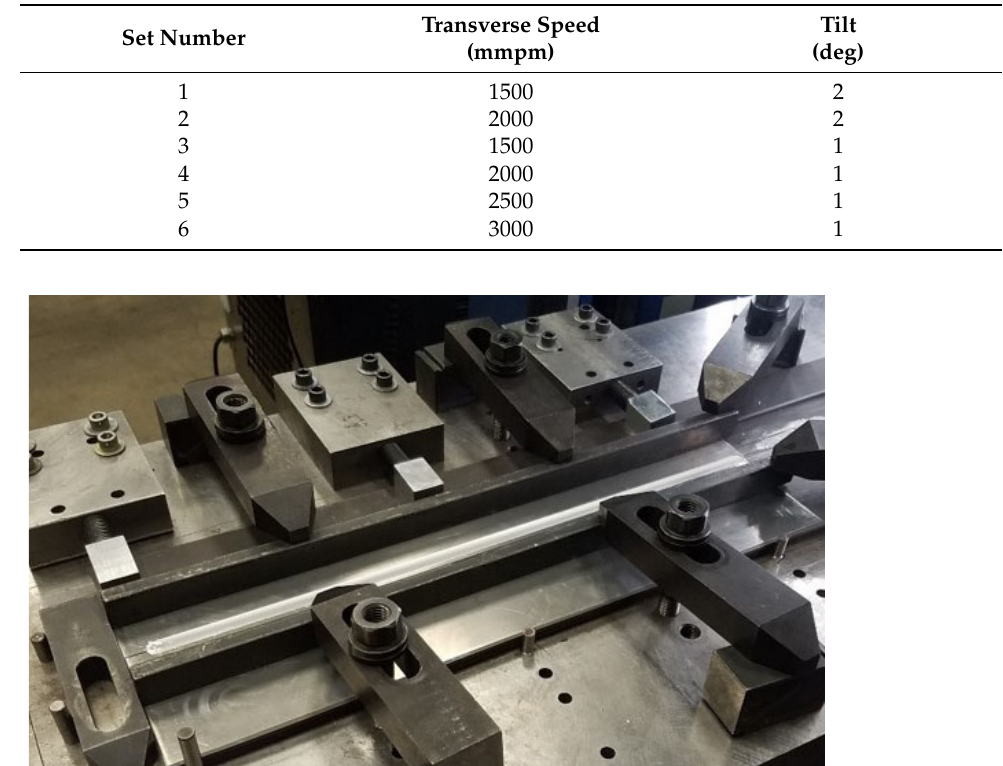
Figure 3. The clamping method and welding table set up for all welds. The X -axis, Y -axis Z -axis forces and torque were sampled at a frequency of 1250